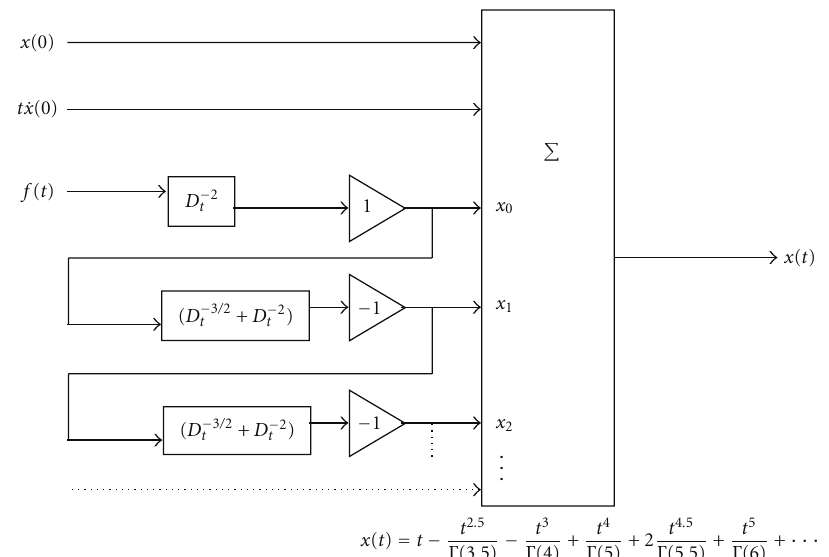
Figure 5: Block diagram showing solution of by decomposition of a second-order di ff erential equation in presence of fractional-order term.